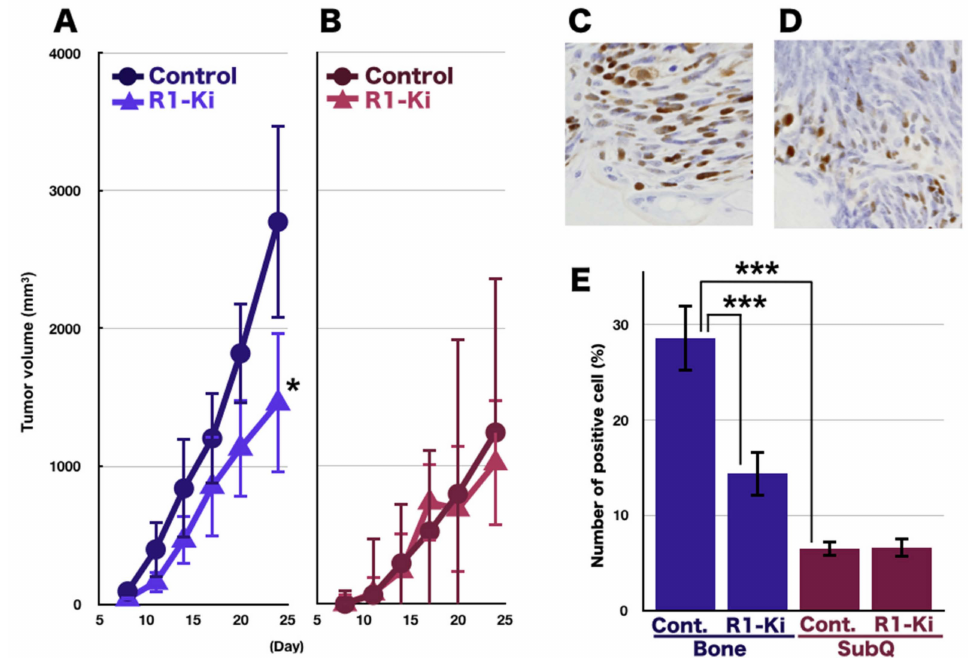
Figure 2. The effects of TGF- β on tumor growth and cell proliferation. ( A ) Tumor size in the bone micro-E: Faster tumor growth in the control group and slower growth in the R1-Ki treatment group. A significant difference in tumor size was observed at Day 24. ( B ) Tumor size in the subQ micro-E: Slow tumor growth regardless of treatment. ( C , D ) Many Ki-67 positive cells in the control group in the bone micro-E ( C ), and fewer positive cells in the subQ micro-E ( D ). Magnification: 600 × . ( E ) Significant suppression of Ki-67 positive cells by the treatment with R1-Ki in the bone micro-E but not in the subQ micro-E. *, ***: p < 0.05, p <